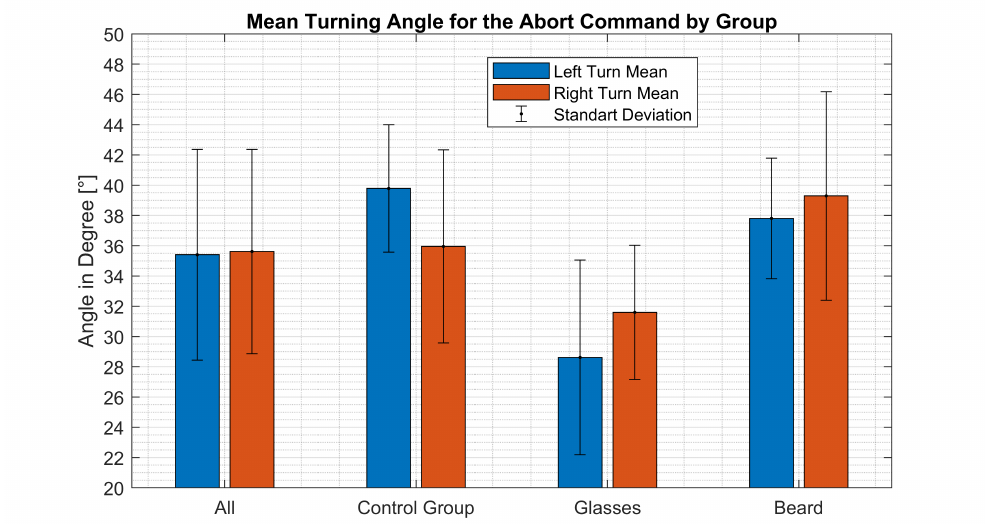
Figure 10. Bar graph of the average turning angles required to trigger the abort condition per group. The blue bars represent the mean value for left turns and the red bars for right